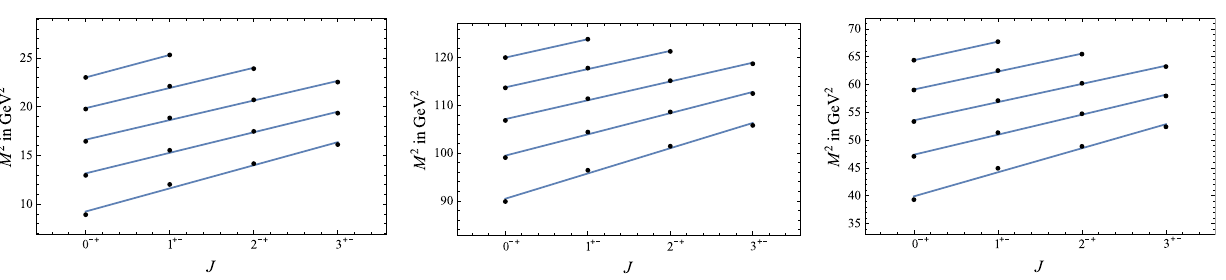
Fig. 1 Parent and daughter Regge trajectories ( J , M 2 ) for charmonia (left), bottomonia (middle) and B c (right) mesons with natural parity ( P = ( − 1 ) J )